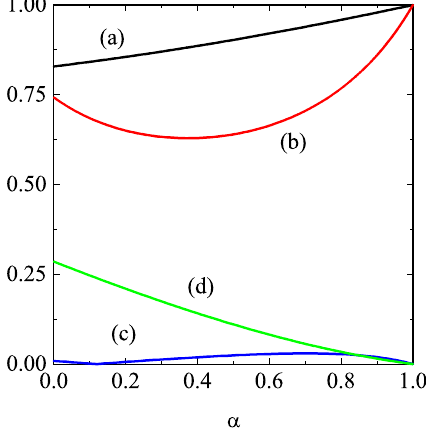
Figure 1. Plot of η ∗ ( α,φ ) /η ∗ (1 ,φ ) (a), κ ∗ ( α, φ ) /κ ∗ (1 ,φ ) (b), µ ∗ ( α,φ ) = n µ ( α, φ ) / ( T κ 0 ) (c), and | | of restitution α for d = 2 and φ = 0 .